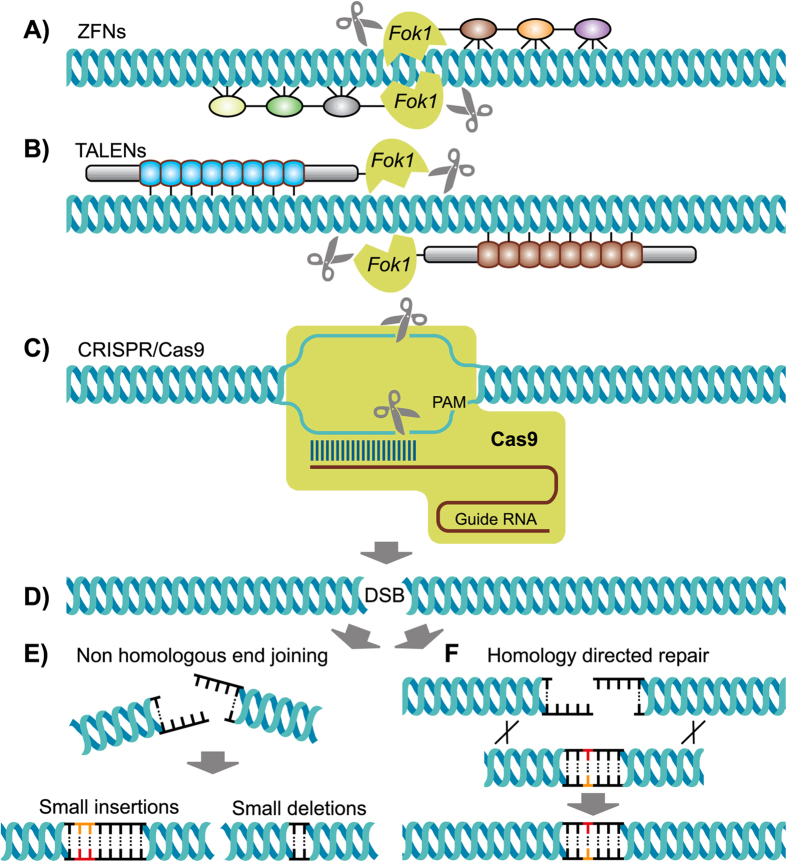
Schematic outline of the application of the three most commonly used genome editors (ZFNs, TALENs, CRISPRs) to introduce targeted genome modifications into animal genomes.ZFNs (A) are chimeric designer proteins that combine a customizable DNA binding domain with the catalytic domain of the restriction endonuclease FokI (green). The DNA binding domain is comprised of several, modular ZFs (colored ellipsoids) that each can bind to a specific triplet of DNA sequence. ZFNs require the coordinated binding of a pair of ZFNs at the target site to gain activity of the dimerization-dependent FokI nuclease. TALENs (B) are following the same principle but are using entirely different DNA binding modules (TALE repeats, blue and brown elements) that each specifically bind a single nucleotide. CRISPR/Cas9 (C) uses a universal nuclease with two catalytic domains (Cas9, green) that is guided to its specific target site by a stretch of 20 nucleotides of sequence complementarity of the guide RNA to the target sequence (indicated as base-pairing between the single stranded target DNA and guide RNA) in addition to the juxtaposition to the protospacer adjacent motif (PAM). All three editors (A to C) have in common that the targeted nuclease will cleave both DNA strands (indicated by the scissors) resulting in a double strand break (DSB) at the target site (D). This DSB can be repaired by the endogenous cellular machinery by non homologous end joining (E) which is an error prone mechanism leading to the frequent introduction of small insertions (colored bases) or deletions. If a homologous template is provided the DSB can be resolved through homology directed repair (F) allowing for the knockin of template-specified sequence variations (novel, colored base pair).